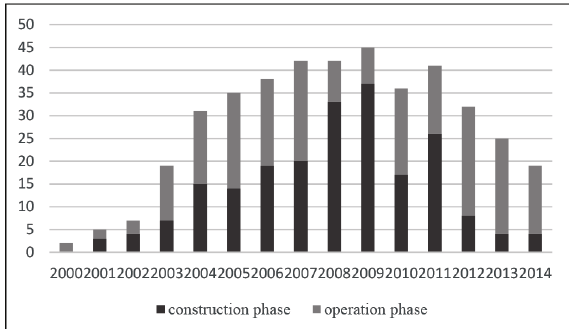
Figure 5. Statistics of total accidents by